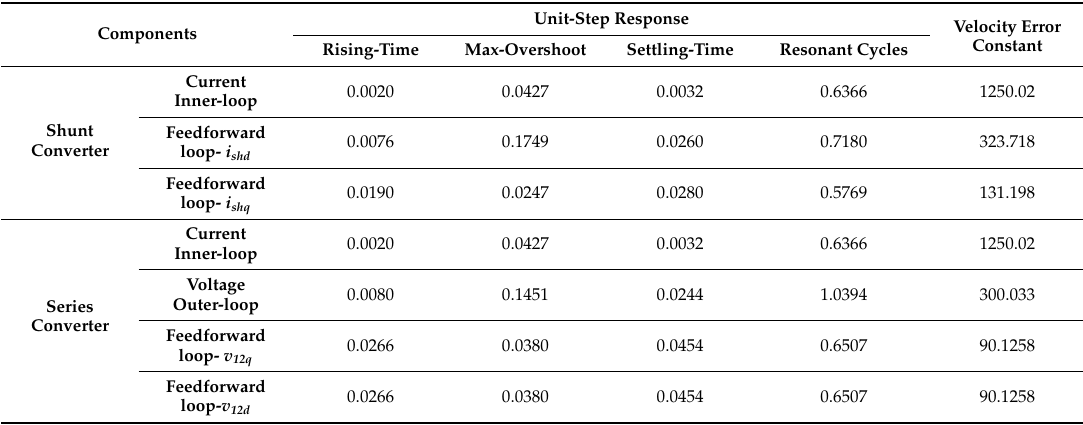
Table 3. The design parameters and performance of the control loops in time domain.